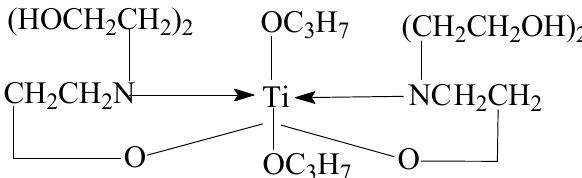
Figure 10. The structure of titanium (IV) (triethanolaminato)isopropoxide.